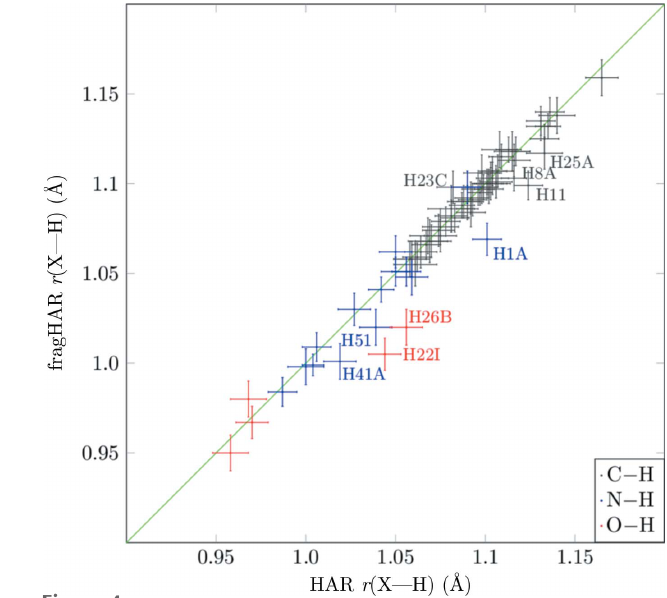
Figure 3 Bond lengths between non-H atoms from fragHAR calculations plotted against reference HAR values. Error bars are depicted, but are invisible to the eye on this